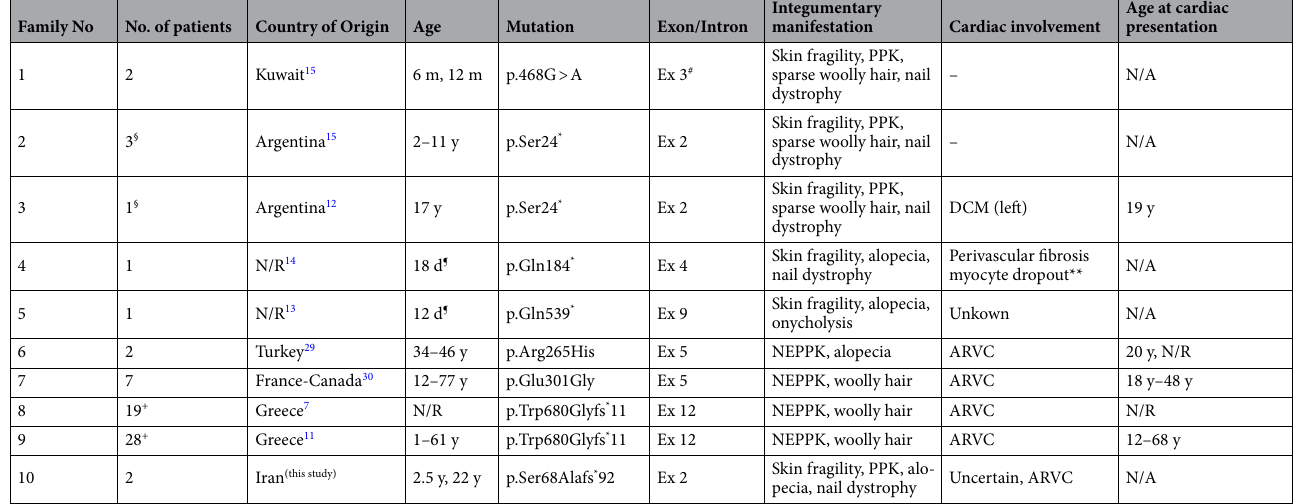
Table 1. Summary of previously reported patients with biallelic homozygous JUP mutations presented with concomitant skin and cardiac manifestations. § , + : The patients are shared; ¶: deceased; d: day; m: month; y: year; N/R: Not reported; N/A: Not available; NEPPK: Non-epidermolytic palmoplantar keratoderma; ARVC: Arrhythmogenic right ventricular cardiomyopathy; DCM: Dilated cardiomyopathy. # Synonymous mutation at the border of exon 3 and IVS 3 resulted in aberrant splicing. **The results of post-mortem